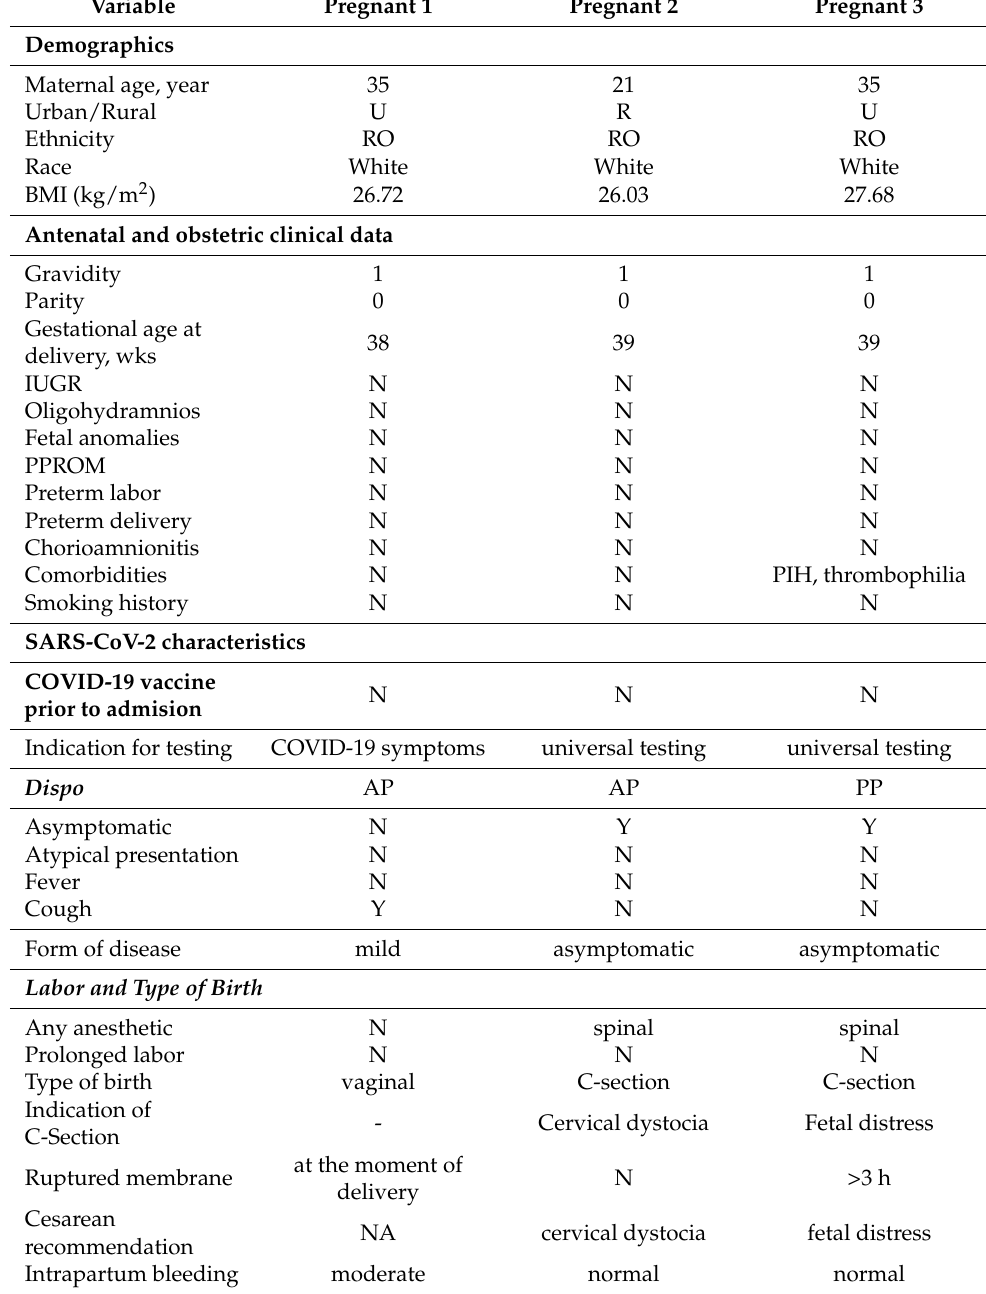
Table 1. Patients’ characteristics and clinical details at